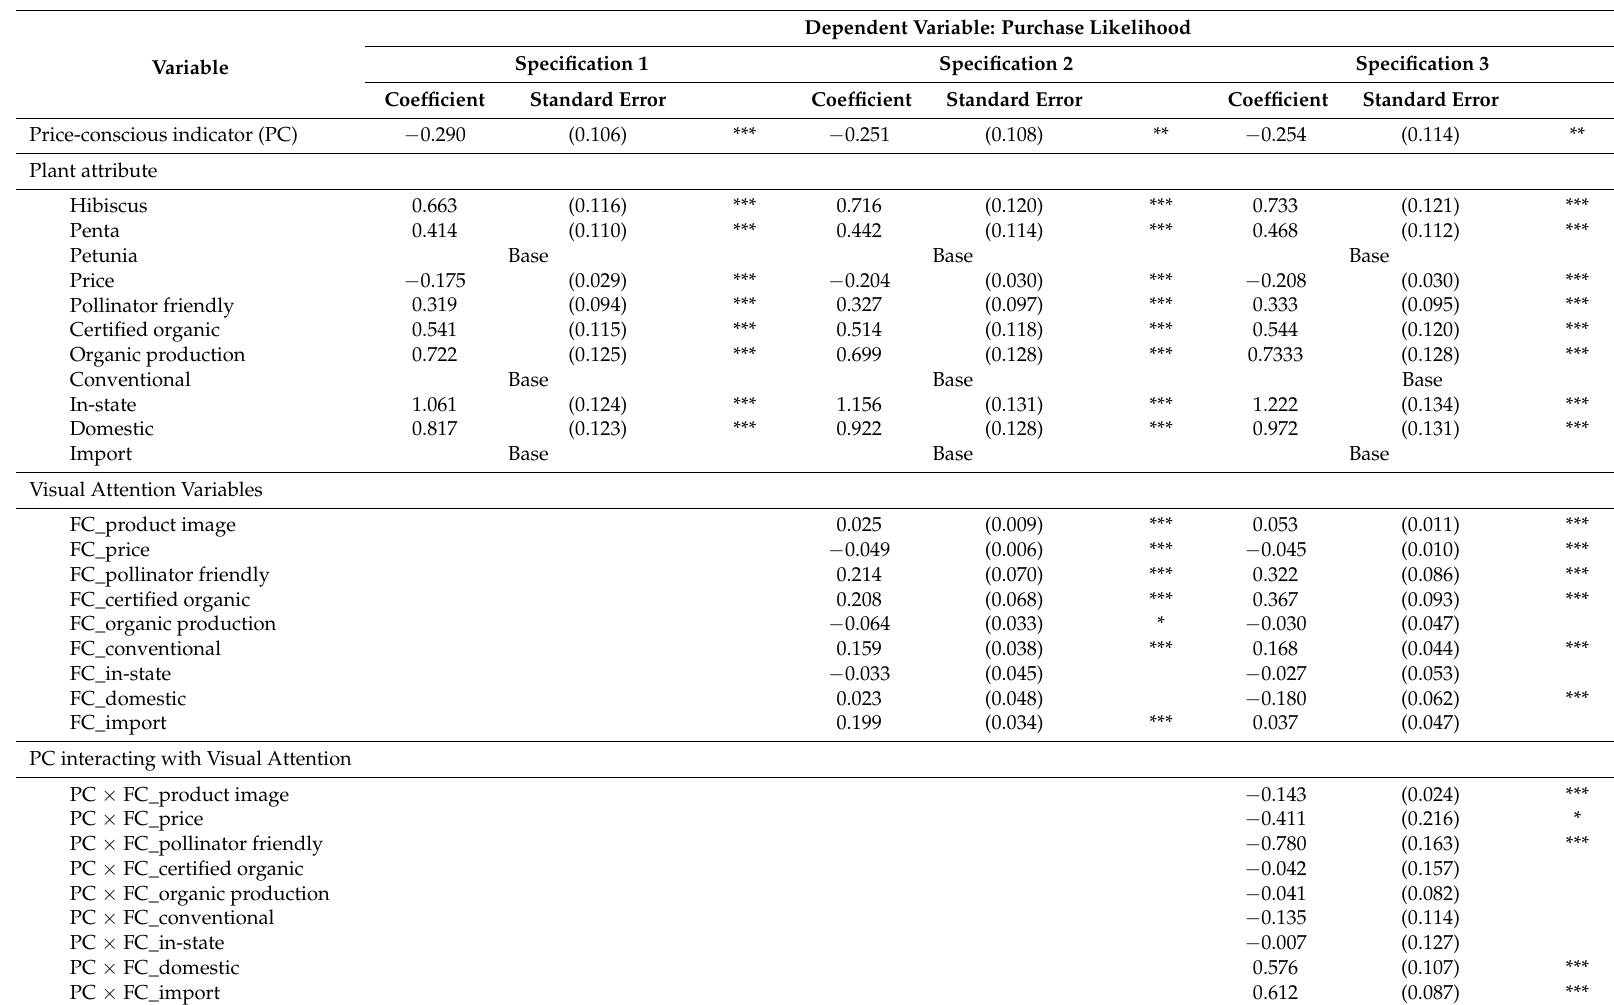
Table 3. Coefficient estimates of consumers’ purchase likelihood of ornamental horticultural plants from the Ordered Logit Regression